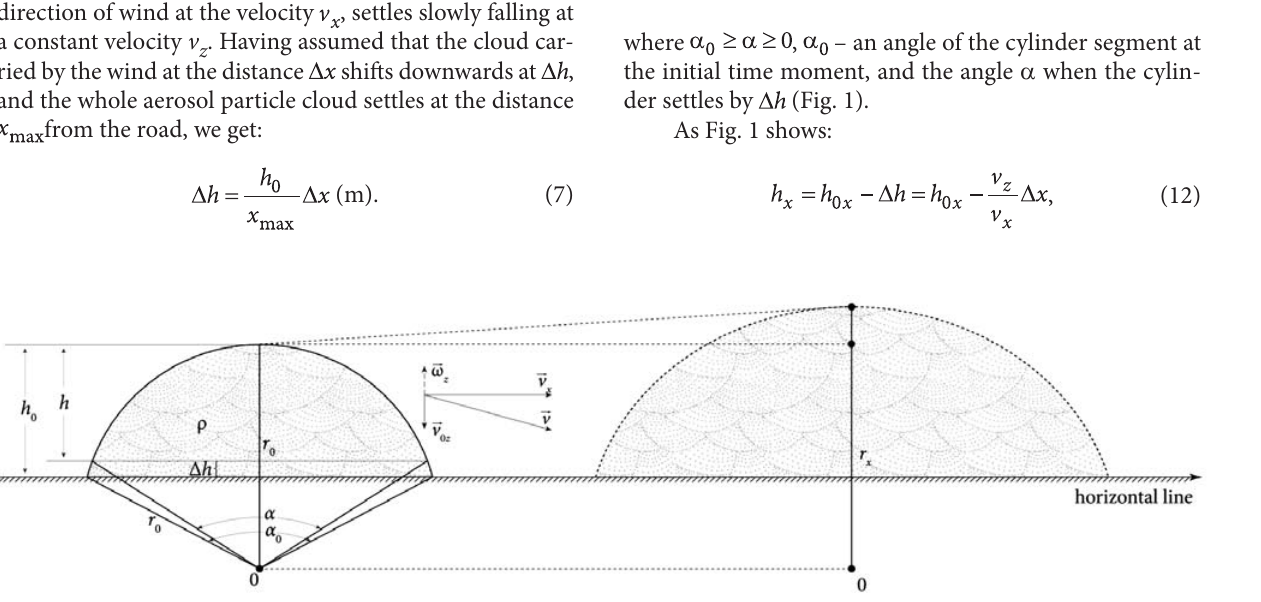
Fig. 1. Development of the whirl of aerosol particles on the ground